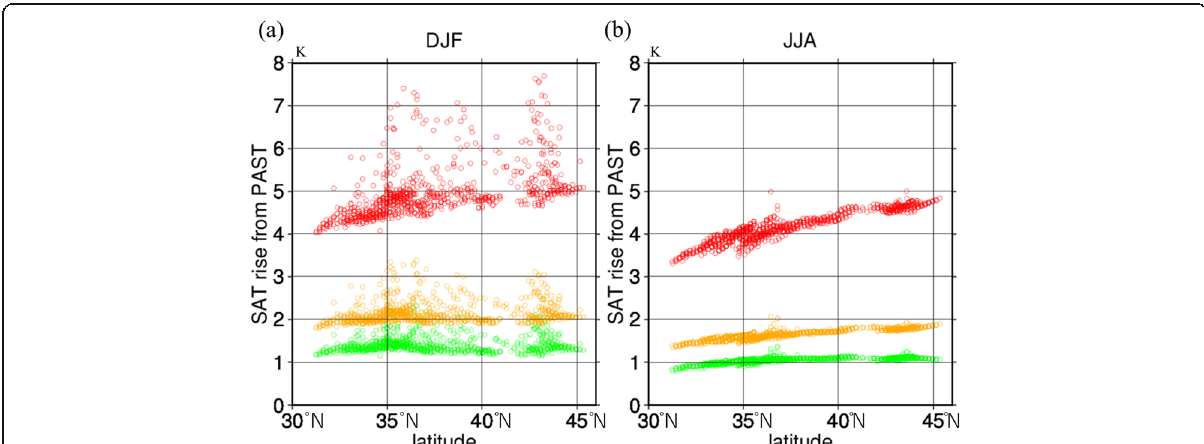
Fig. 5 Scatter plots of increases in seasonal mean SAT relative to the present climate as a function of latitude. a DJF and b JJA. Values at all land grids on the Japanese Islands were used and were based on 1450 years average for PAST and 1566 years average for the future climate. The green, yellow, and red circles indicate d1.5, d2, and d4, respectively